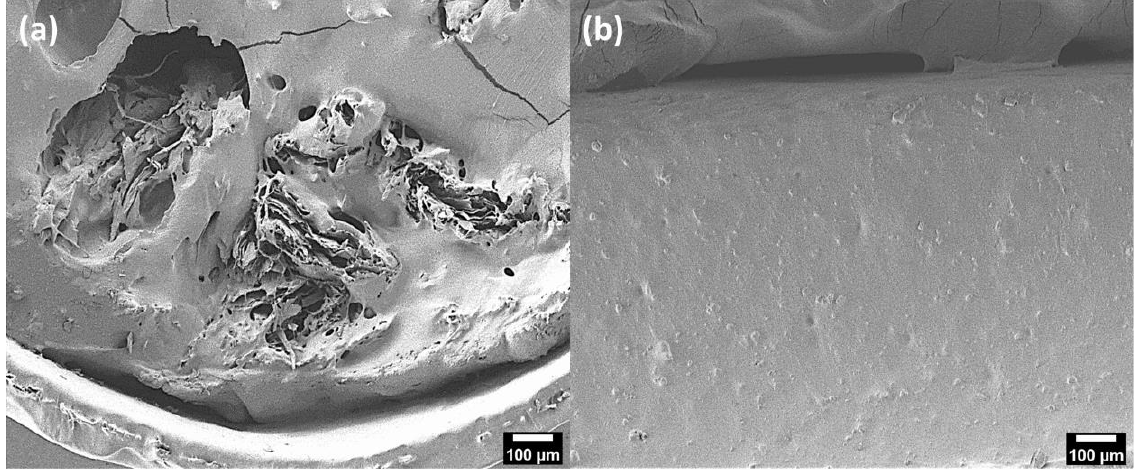
Figure 7. FE-SEM images of cross-section ( a ) FD-CNFs–PHA; ( b )